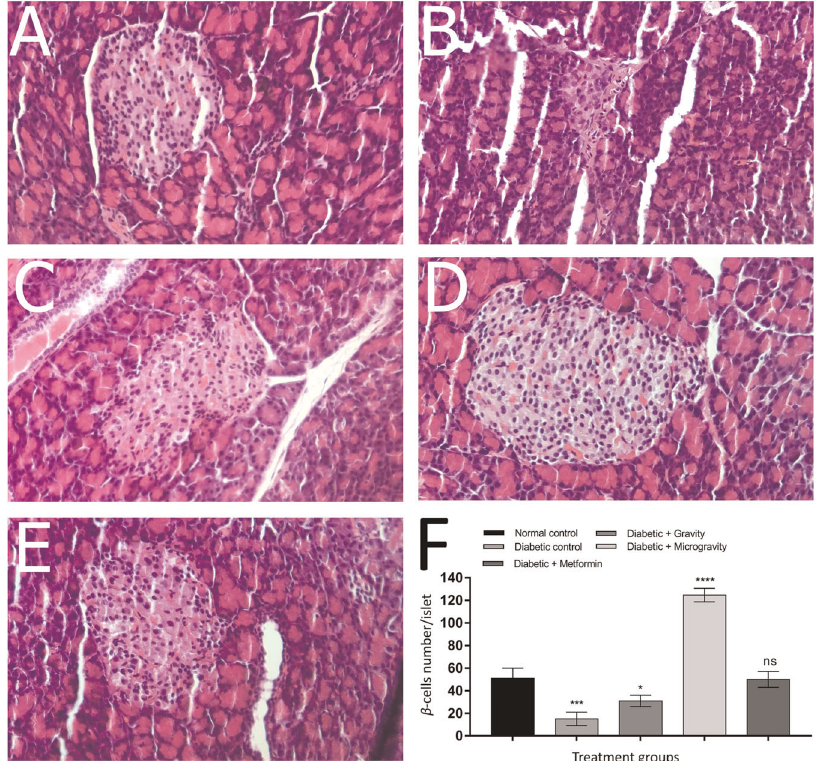
Fig. 6 Photomicrographs of H&E-stained histological slides of pancreatic specimens. a Normal histological appearance of the islets of Langerhans from the pancreases of rats in the control group. b The pancreases of rats in the diabetic control group showed degeneration, necrotic changes, and islet shrinkage. c The appearance of pancreas sections from rats administered the ethanolic extract of T. aestivum under gravity conditions showed improved islet morphology. d The appearance of pancreas sections from rats administered the ethanolic extract of T. aestivum under microgravity conditions showed the normal structure of the pancreatic islets of Langerhans. e shows that there were no pathological changes in the islets of Langerhans of the pancreas in diabetic rats treated with metformin. Original magni fi cation was ×400. f The pancreatic β cell number per islet in different treatment groups. Groups were compared to the control untreated group. As shown in the fi gure, microgravity extract treatment had a highly signi fi cant effect on the pancreatic β cell number per islet compared to the normal untreated control group. Data were compared against data for the normal control by using one-way ANOVA with Bonferroni ’ s multiple comparisons test with the level of signi fi cance at P < 0.05. *, ***, ****, ns = P < 0.05, P < 0.001, P < 0.0001, and nonsigni fi cant,